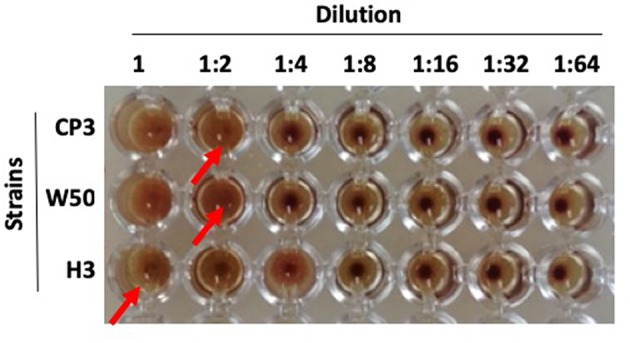
Hemagglutination activity of Porphyromonas gingivalis strains CP3, H3, and W50. Hemagglutinin activities of P. gingivalis (W50, H3, and CP3) were assessed in cells serially diluted (from left to right) and incubated with sheep erythrocytes (2%) in a round-bottom microtiter plate. Dilution folds were listed on the top. Red arrows indicate the last dilution that showed full agglutination. The figure is representative of three biological replicates.